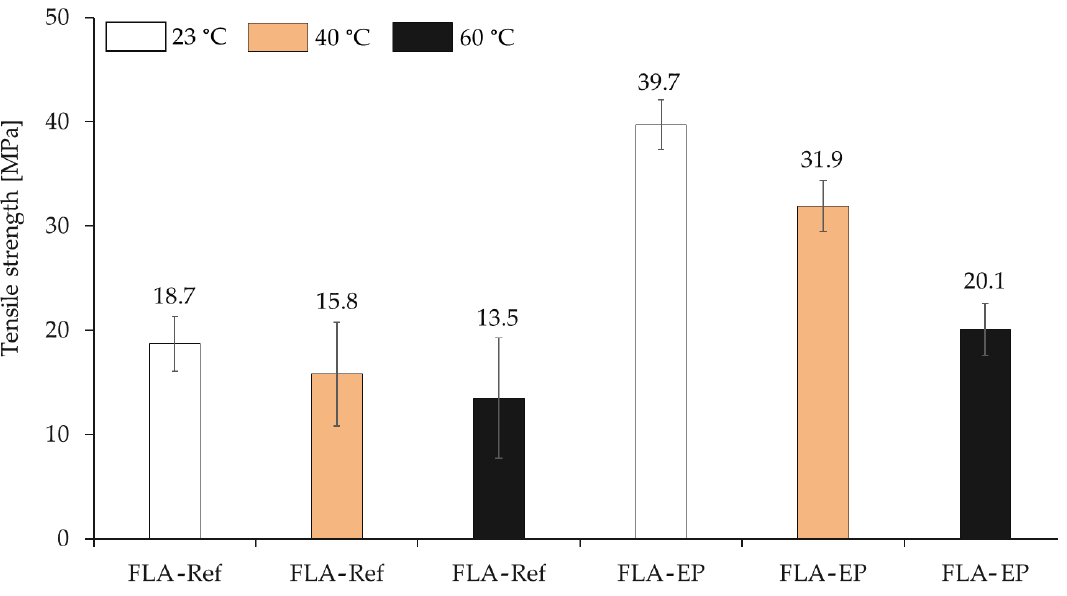
Figure 3. Tensile strength of flax textiles at 23 °C, 40 °C and 60 °C.